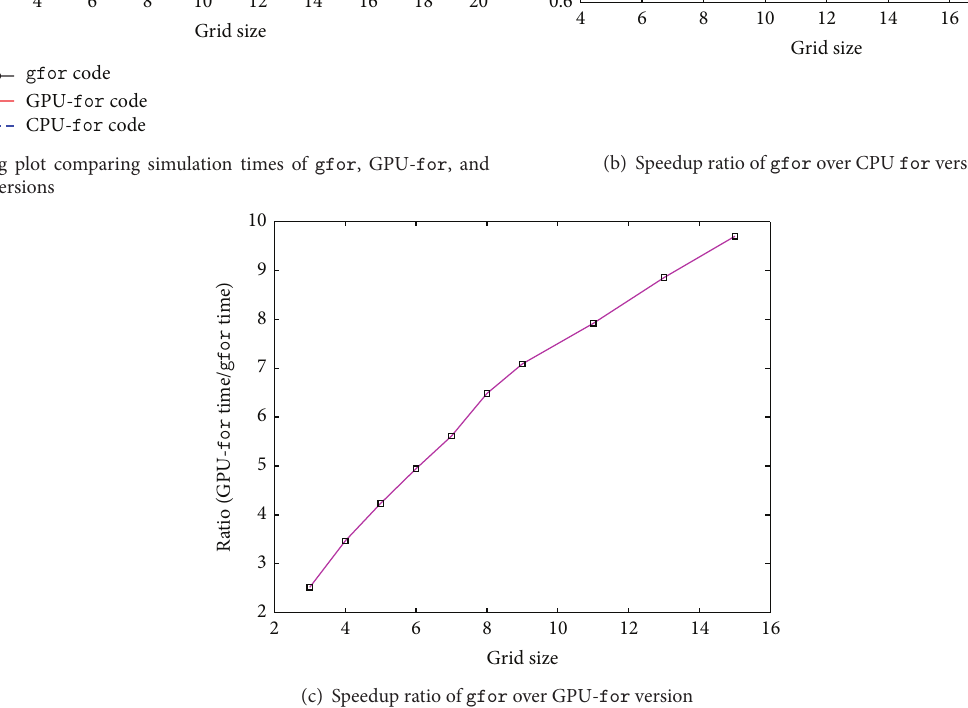
Figure 2: Comparison of simulation times and speedup ratios of PBM code incorporating gfor , GPU- for , and CPU- for .